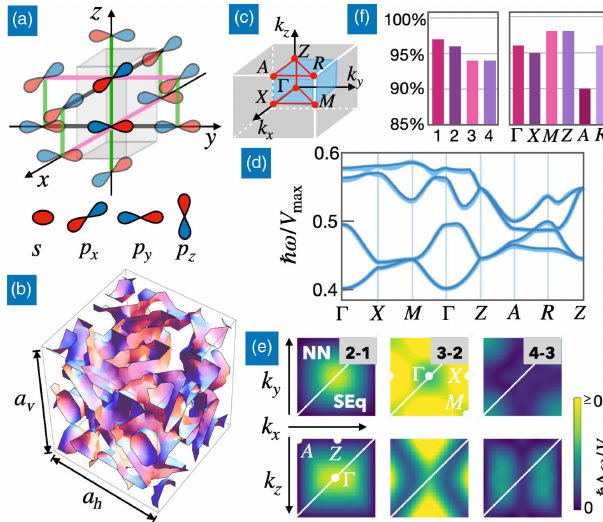
FIG. 4. Neural-network-based prediction of 3D band structures for potential distributions in the p 4 2 22 nonsymmorphic space group. (a) Sketch of the symmetry-enhanced TB model. Pairs of orbitals localized about different sublattices are mapped onto each other via screw rotations. Symmetry-related nearest- neighbors transitions are highlighted in the same color. The different orbital types (bottom) transform according to the different representations of the point group D 2 (twofold rotations about the axes x , y , and z ); see the Appendix. (b) Example of steplike potential with p 4 2 22 space group. (c) BZ and high- symmetry path for the primitive tetragonal lattice. (d) Band structure along the high-symmetry path. (e) Comparison of NN and Schrödinger equation predictions for the first three band gaps on two different 2D cuts of the BZ. [The results in (d) and (e) refer to the validation potential shown in (b).] (f) Fraction of correctly predicted symmetry labels ordered by band and high- symmetry